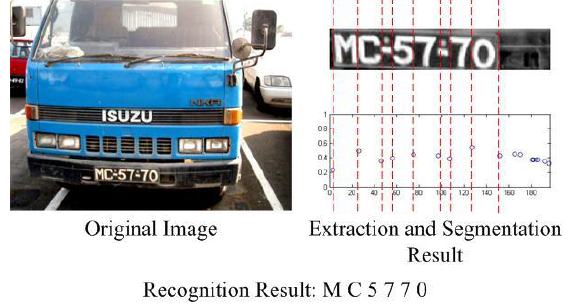
Figure 15: Experimental result with plate-like